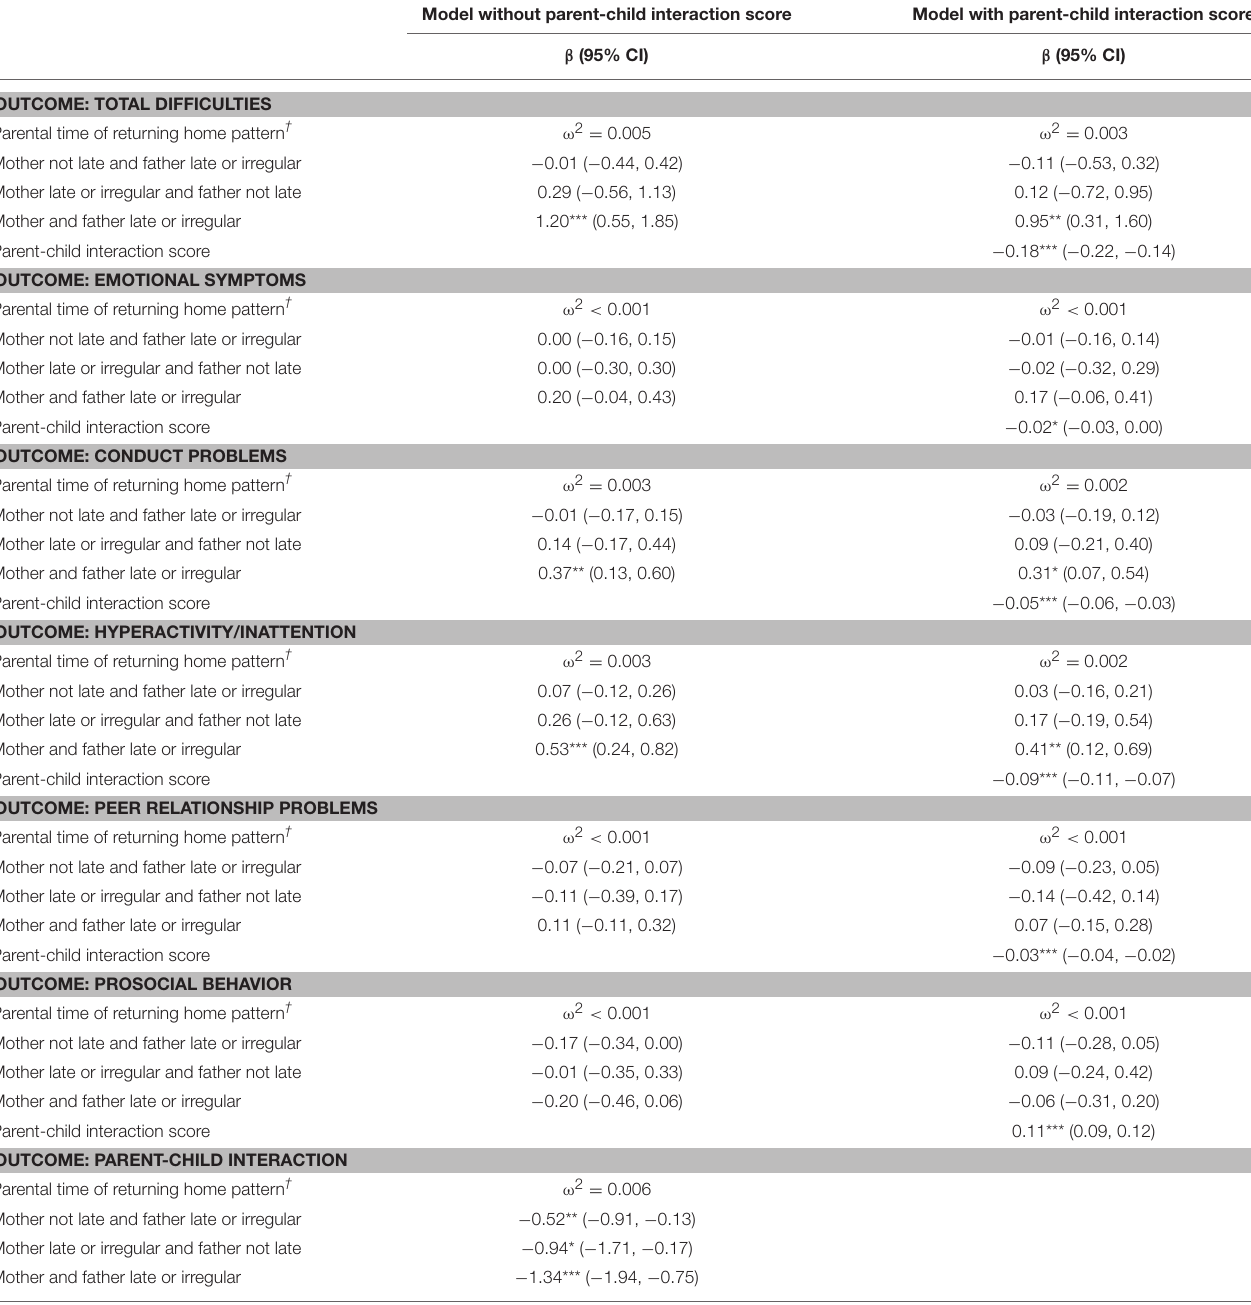
TABLE 3 | Multivariable linear regression models for Child Strengths and Difficulties Questionnaire scores and a parent-child interaction score. Model without parent-child interaction score Model with parent-child interaction score β (95% CI) β (95%